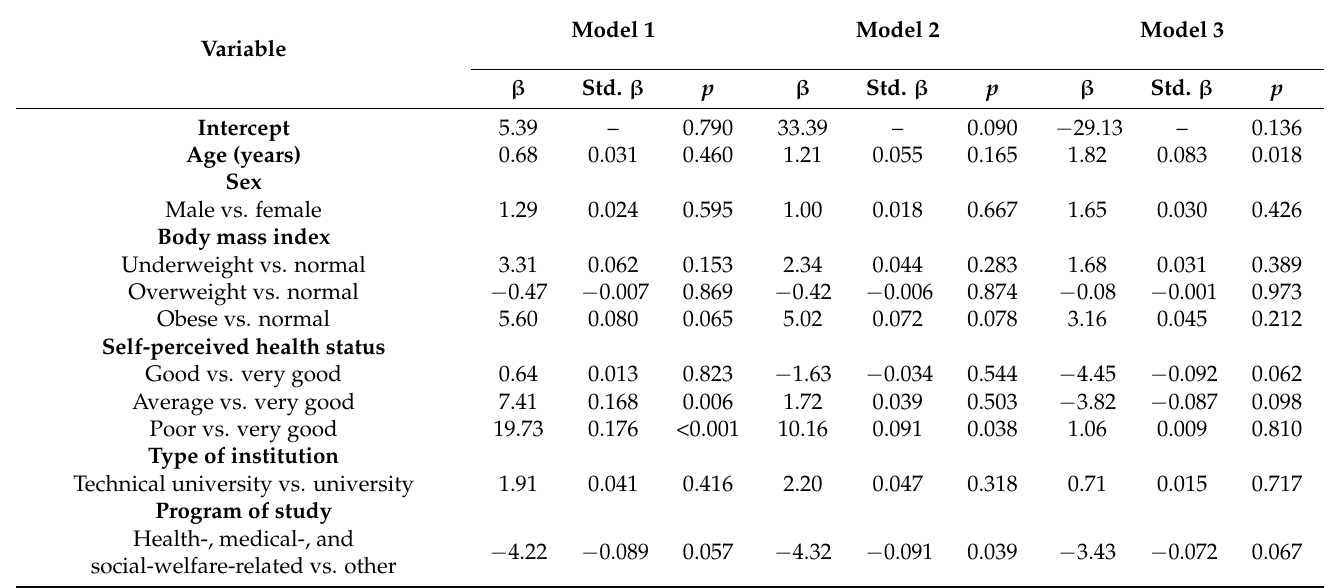
Table 2. Hierarchical linear regression analysis of DASS-21 scores (N =